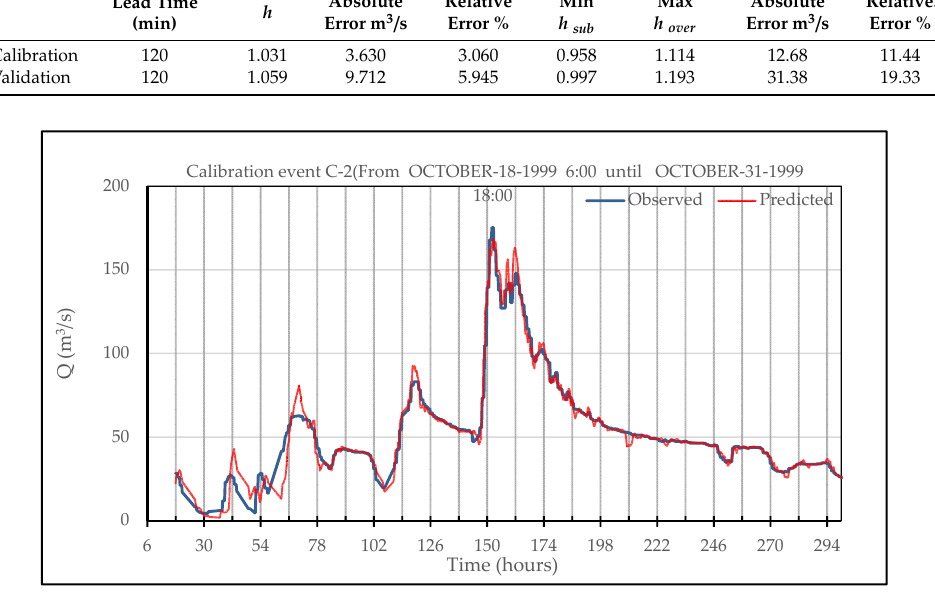
Figure 12. Comparison of flow forecasts and observed outflows at the Graus station (calibration event C2).